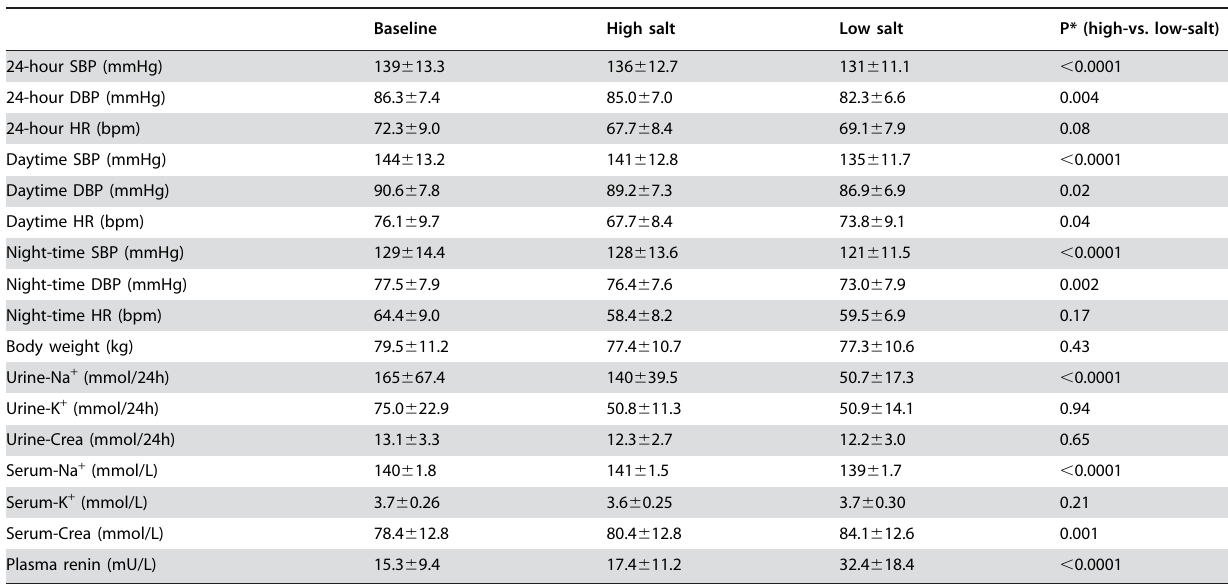
Refer to individual change of variable on high- as compared with on low-salt (i.e. variable D -value). SBP, systolic blood pressure; DBP, diastolic blood pressure; Crea, Creatinine; HR, heart rate.